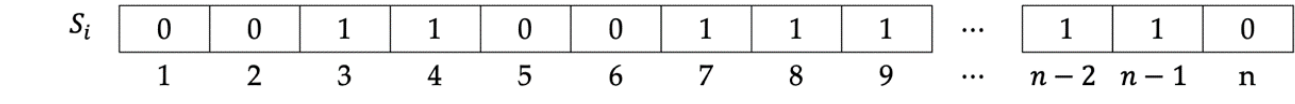
Figure 9. Representation of the initial solutions 𝑆 𝑖 in SA-PCA